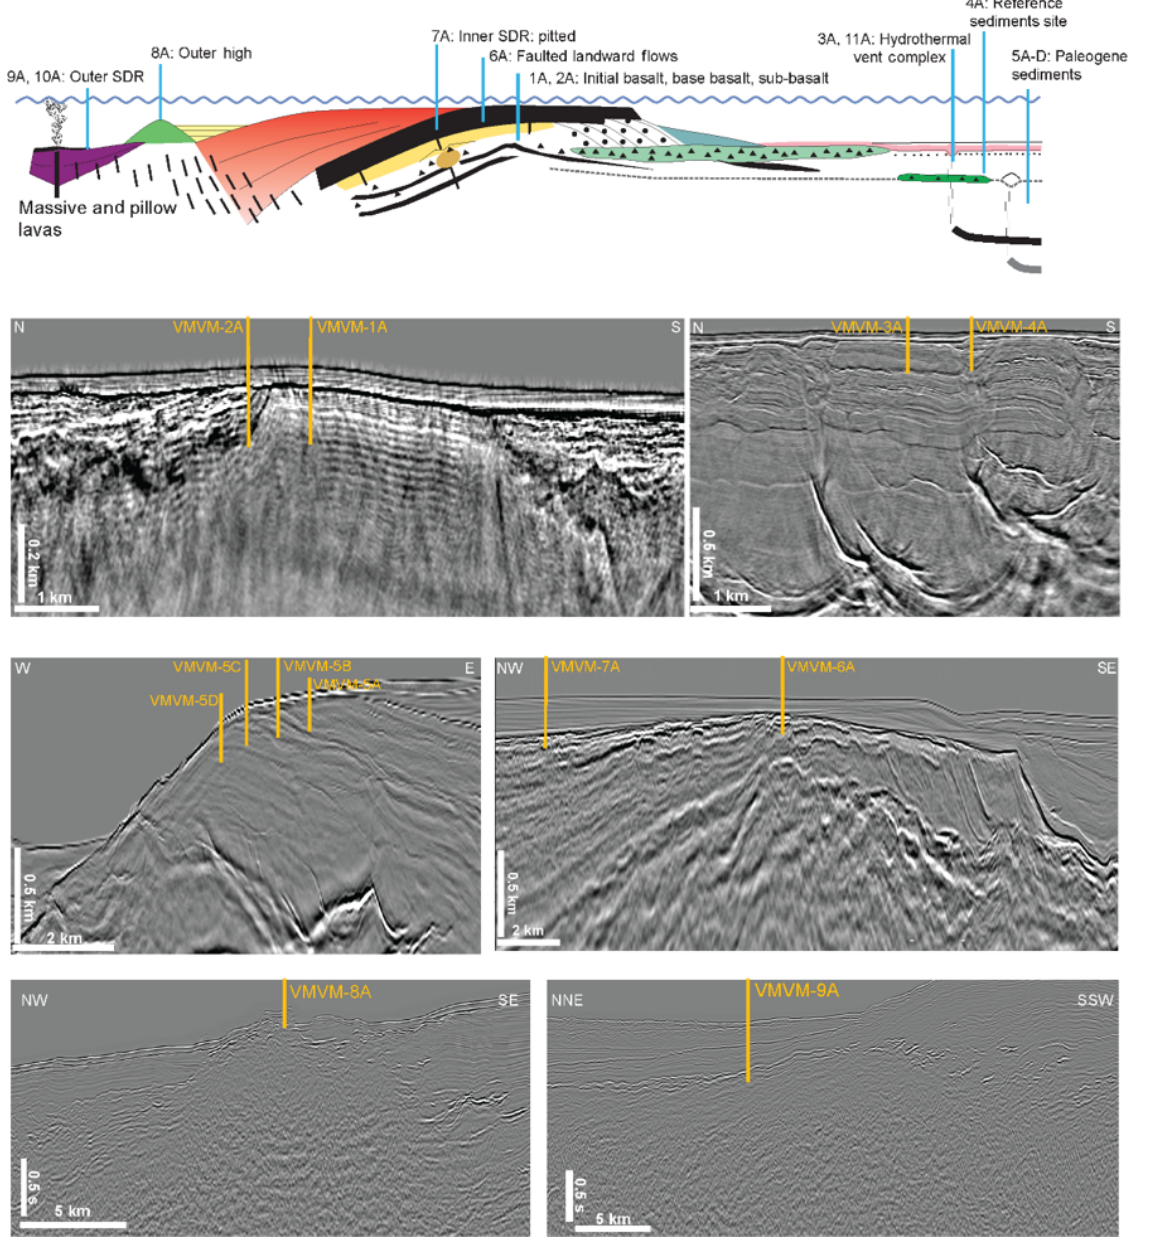
Figure 5. Volcanic seismic facies unit sketch (after Planke et al., 2000) showing schematic location of potential drill sites (top) and modern seismic reflection data showing sites proposed in IODP proposal 944 resulting from the workshop. In sequence (grey panels: left to right, top to bottom) these will test the landward flows, hydrothermal systems linked to sill intrusions, the host rock, the seaward dipping reflectors, the outer high facies, and the outer seaward dipping reflectors (data courtesy of TGS, more information at https://www.tgs.com/, last access: 17 November